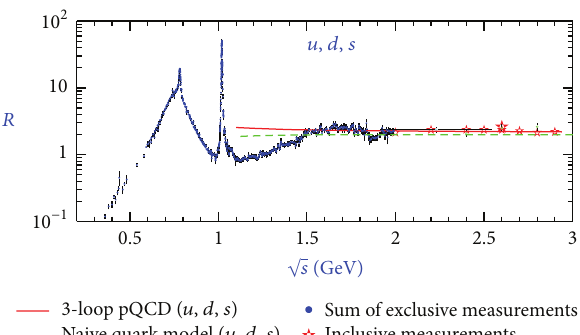
Figure 1: Compilation of experimental data for the ratio, 𝑅 , of cross sections for 𝑒 + 𝑒 − → hadrons over 𝑒 + 𝑒 − → 𝜇 + 𝜇 − , as a function of invariant mass √𝑠 = 𝑀 . Figure taken from